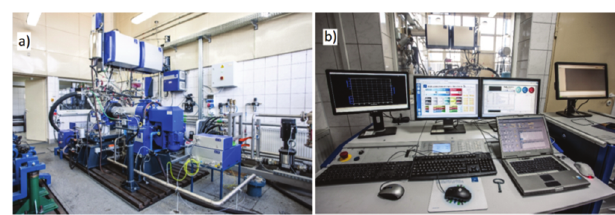
Fig. 2. AVL test bed: (a) general view of the test bed, (b) view of the control